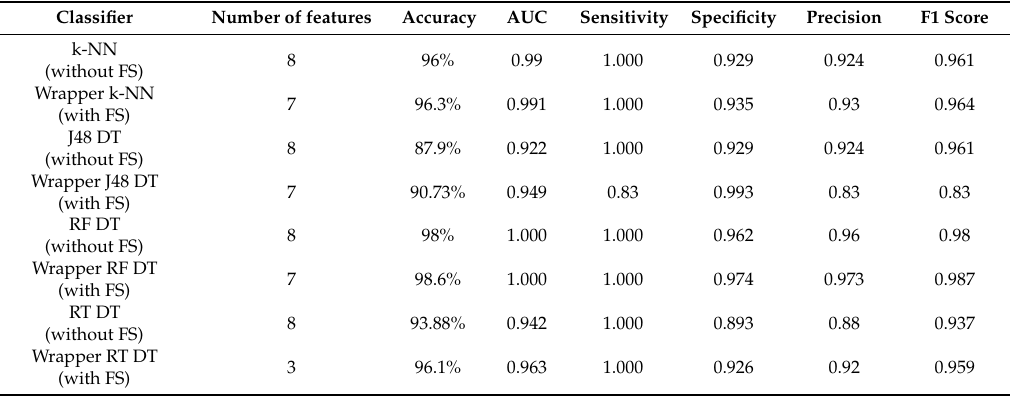
Table 6. The classification results before and after feature selection results using best first (stepwise forward and backward search strategy) for the digital mammography dream challenge.